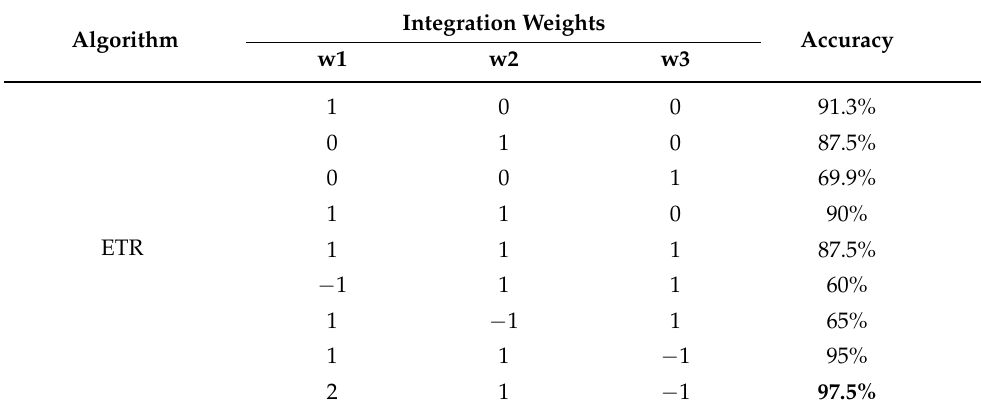
Table 4. Classification results using different integration